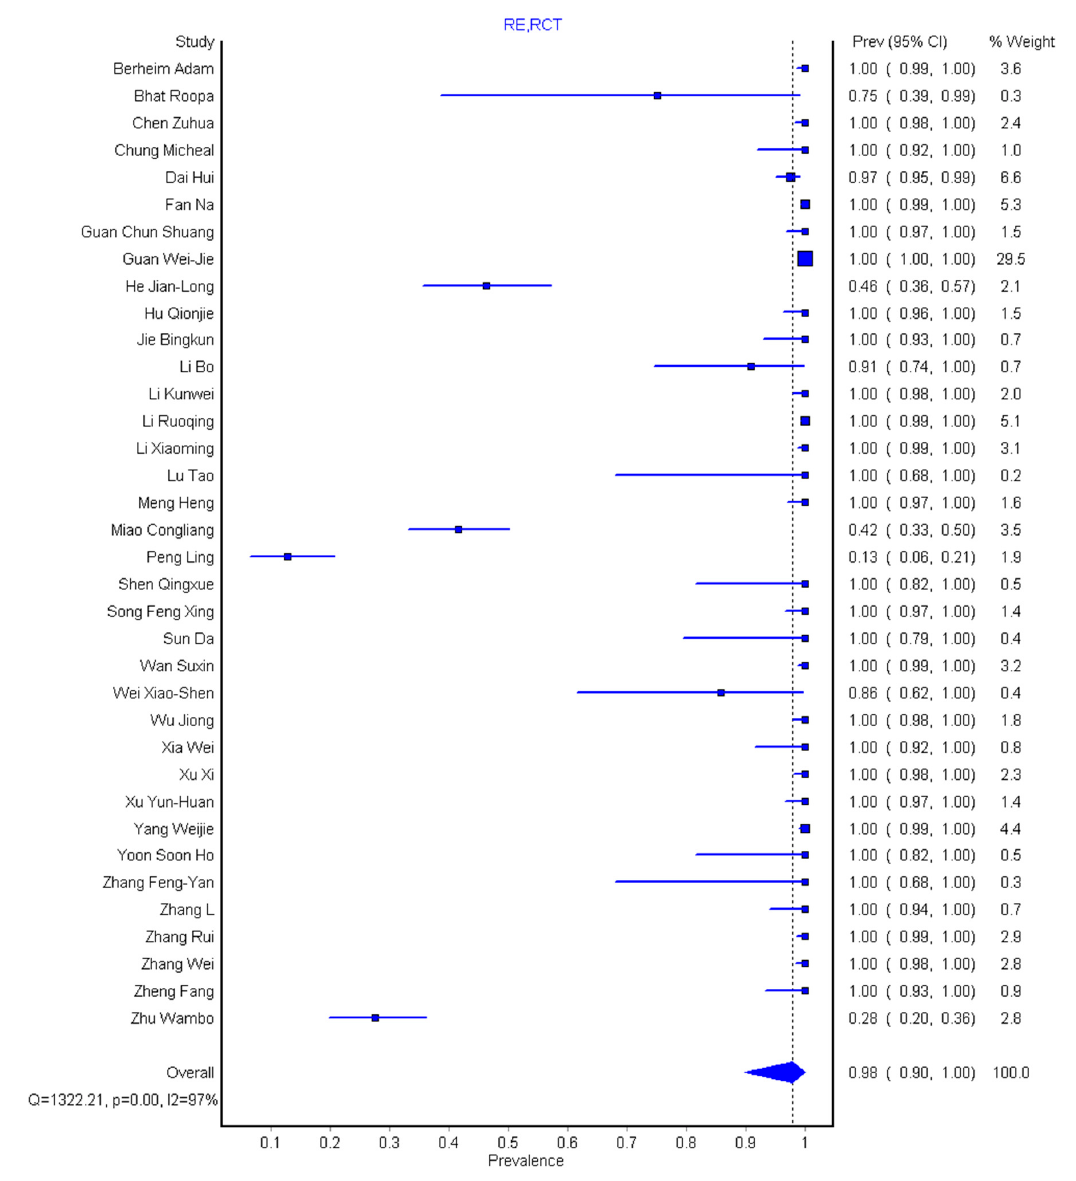
Figure 3. Forest plot of the pooled sensitivity studies for reverse transcriptase-polymerase chain reaction